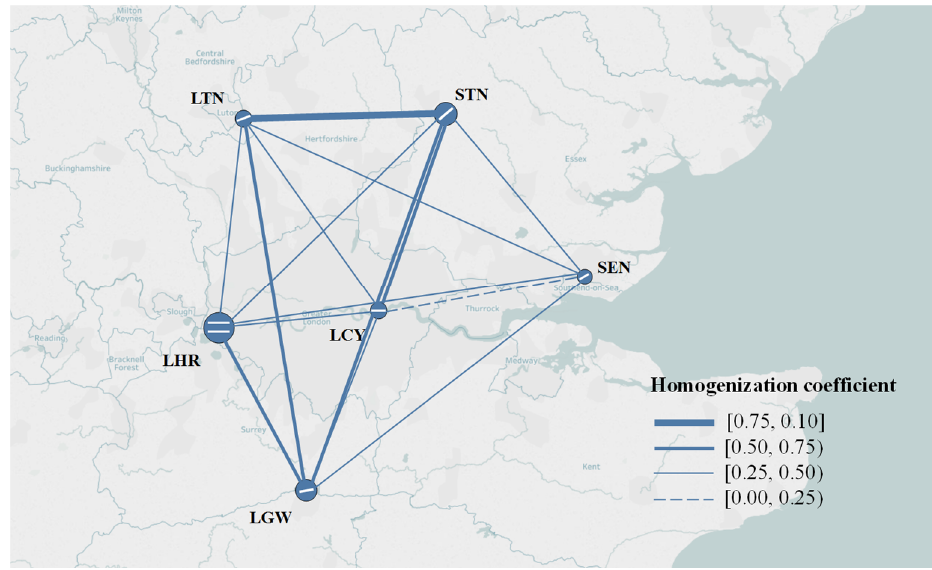
Figure 9. Illustration of comprehensive homogenization of the London MAR. As shown in Tables A1–A5 and 2, homogenization coefficients between LTN and STN were 0.94 in BF, 0.85 in IS, 0.89 in OE, 0.49 in RN and 0.74 in BS. Although homoge- neous levels were extremely high in BF, IS, OE and BS, the homogeneous level in RN was